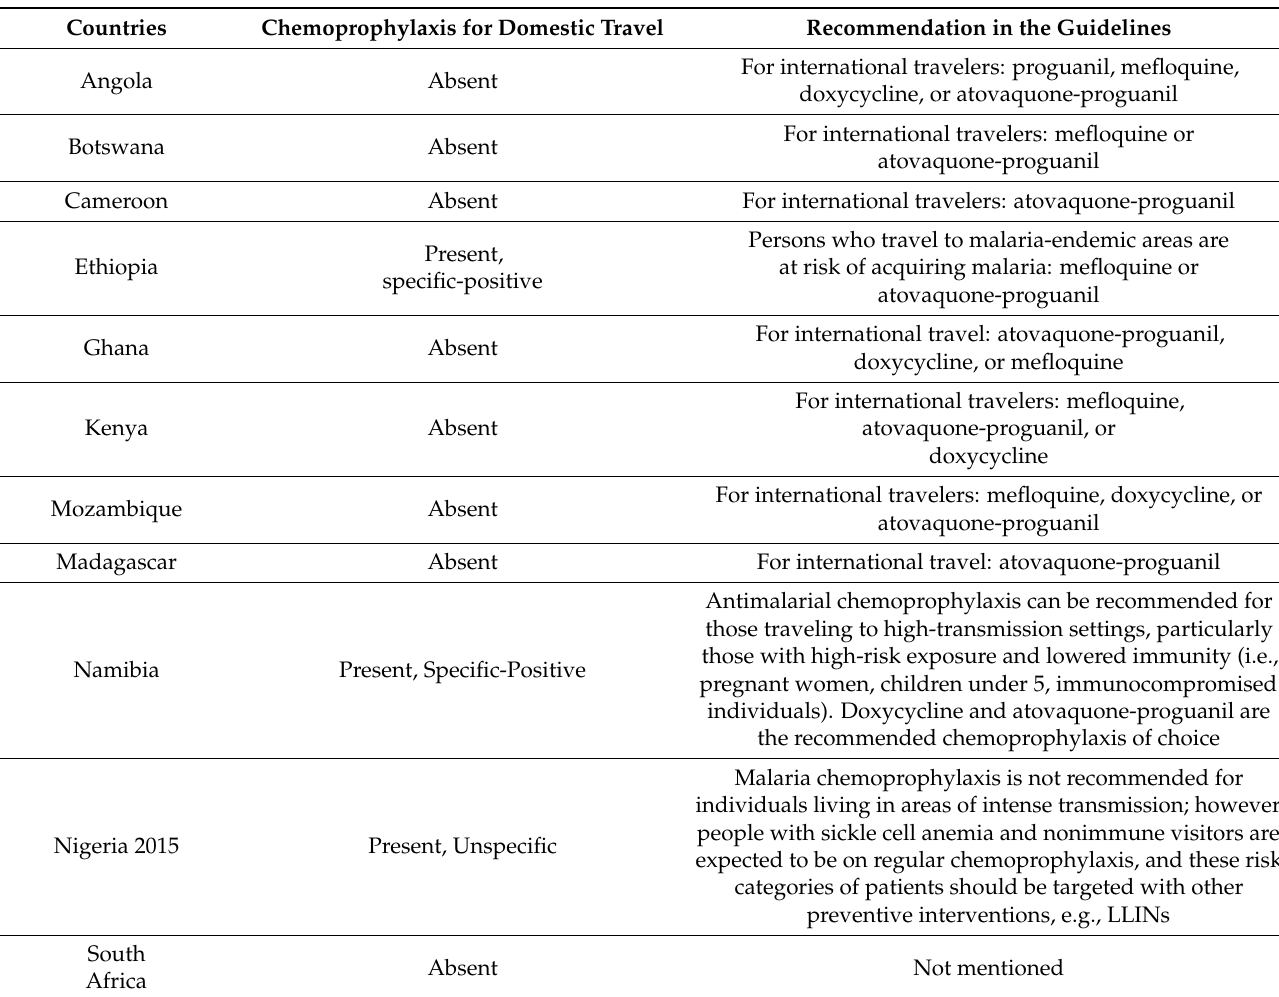
Table 3. Survey results for the Africa